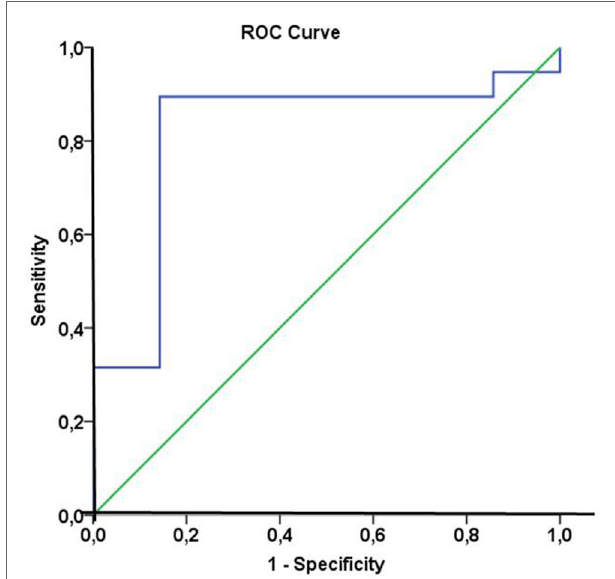
FigUre 4 | Receiver operating characteristic (ROC) curve analysis of heat shock protein 70 (Hsp70) plasma levels of non-small-cell lung cancer (NSCLC) patients (M0) to predict therapy response. Area under the curve = 0.82, p = 0.014. The optimal cutoff value for distinction of responders and non-responders was an Hsp70 plasma level of 4.35 ng/ml with a sensitivity of 0.895 and a false positive rate of